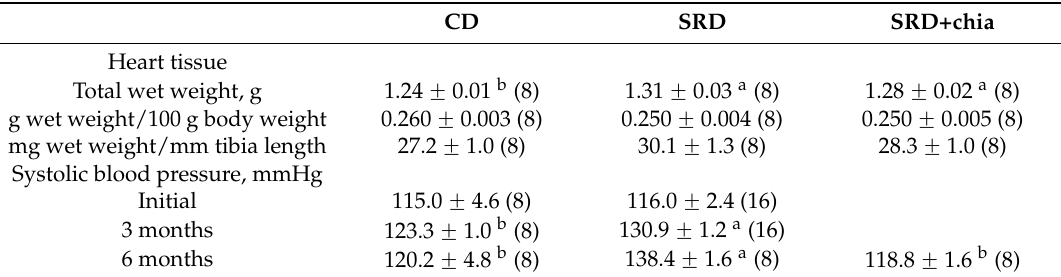
Table 4. Total and relative heart weight at the end of the experimental period and systolic blood pressure of rats fed a control diet (CD), sucrose ‐ rich diet (SRD) or SRD + chia seed (SRD + chia) 1 .